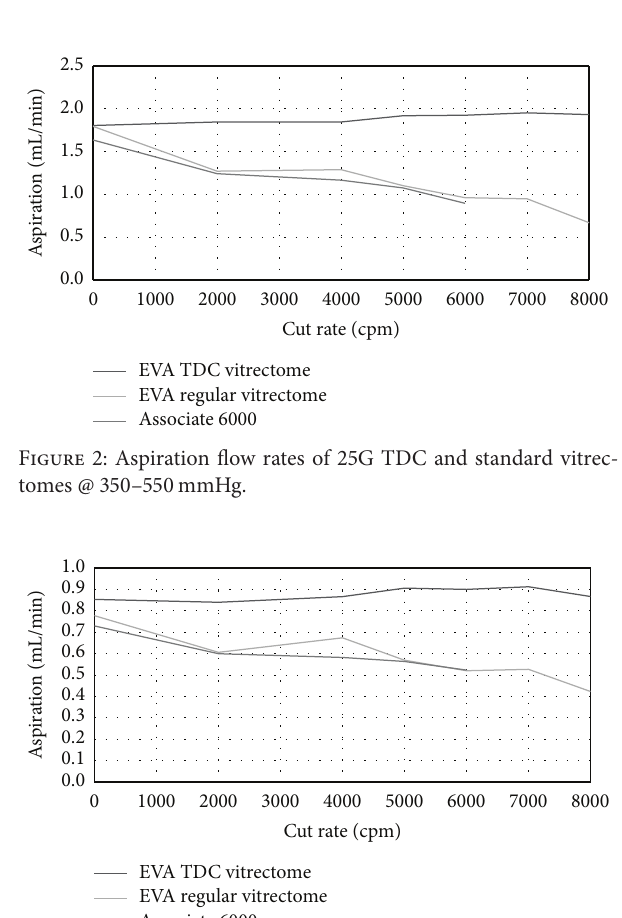
data show that the mean duration of PPV performed using a than the mean duration measured for PPV using a standard 27-gauge single-cut vitrectome; similarly, for 25-gauge PPV, the respective reduction in duration of surgery using a